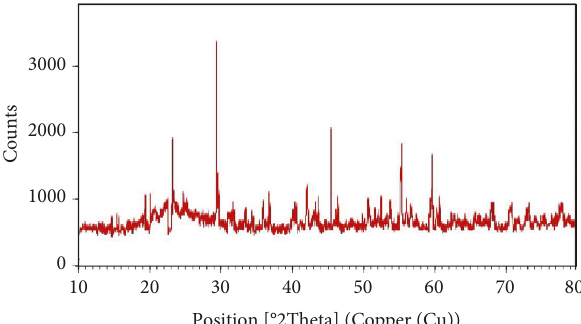
Figure 5: The results represented the crystalline nature of biosynthetic nanoparticles.